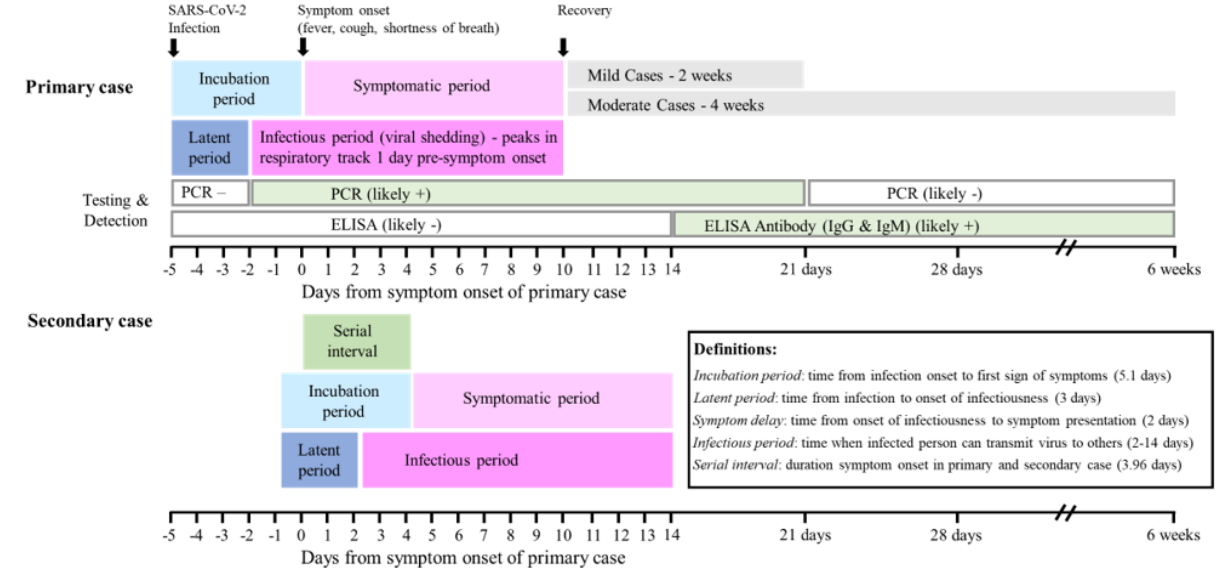
Figure 1. Overview of current estimates on key epidemiological features, infection characteristics, transmission dynamics, and testing methods for SARS-CoV-2 and the coronavirus disease. ELISA: enzyme-linked immunosorbent assay; IgG: immunoglobulin G; IgM: immunoglobulin M; PCR: polymerase chain reaction; SARS-CoV-2: severe acute respiratory syndrome coronavirus